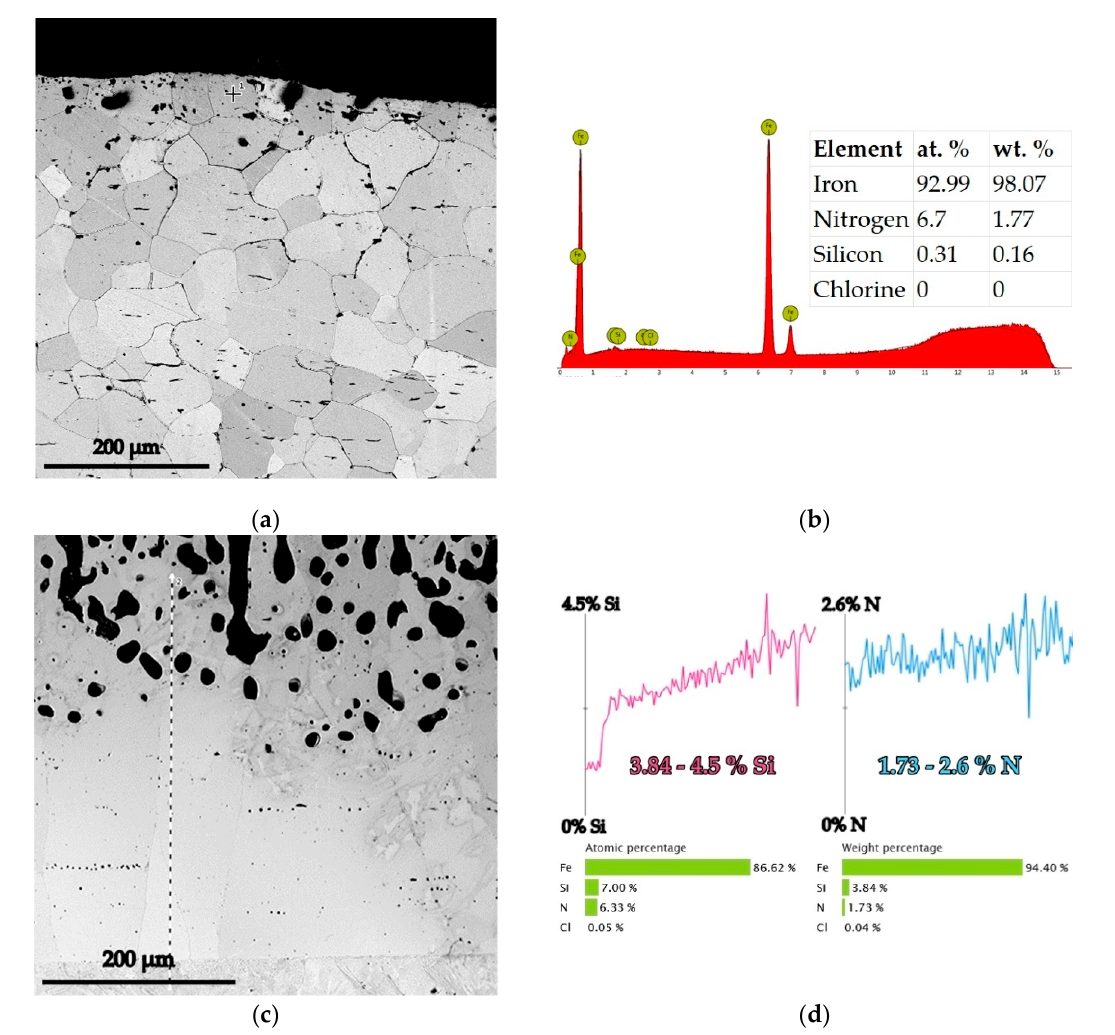
Figure 5. The change in the growth kinetics of the silicon cemented layer (dense and adherent zone) generated by the variation of temperature, the holding time on temperature, and the proportion of ferrosilicon (FeSi75C), namely the proportion of ammonia chloride in the solid powdered mixture utilized. ( a ) 950 °C/5 h; 60% FeSi75C; 3%NH 4 Cl; ( b ) Max. values of the %Si and %N in layer; ( c ) 1150 °C/5 h; 60% FeSi75C; 3% NH 4 Cl; ( d ) Variation of the Si (red line) and the N (blue line) in the Si cemented layer.